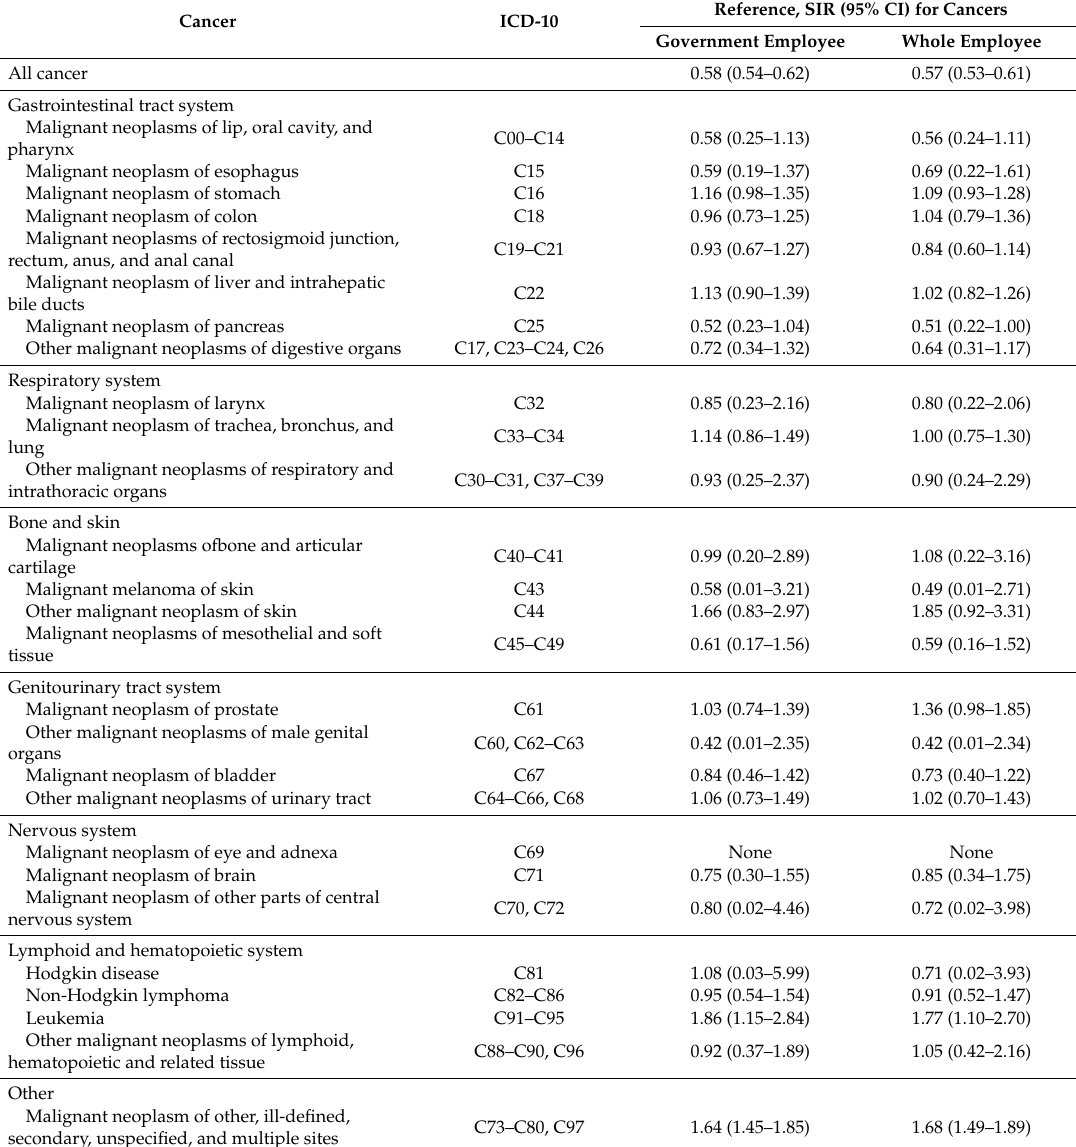
Table 2. The age-standardized incidence ratios (SIR) and 95% confidence interval (CI) of the air transportation industry male workers for cancers according to the reference